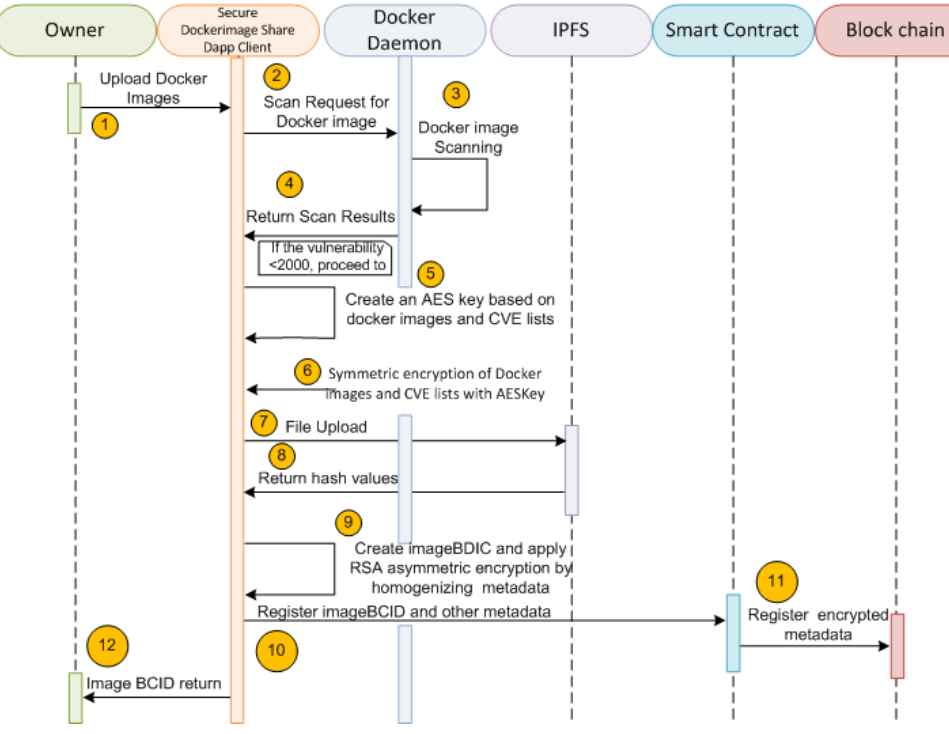
Figure 2. Sequence flow of the secure docker image